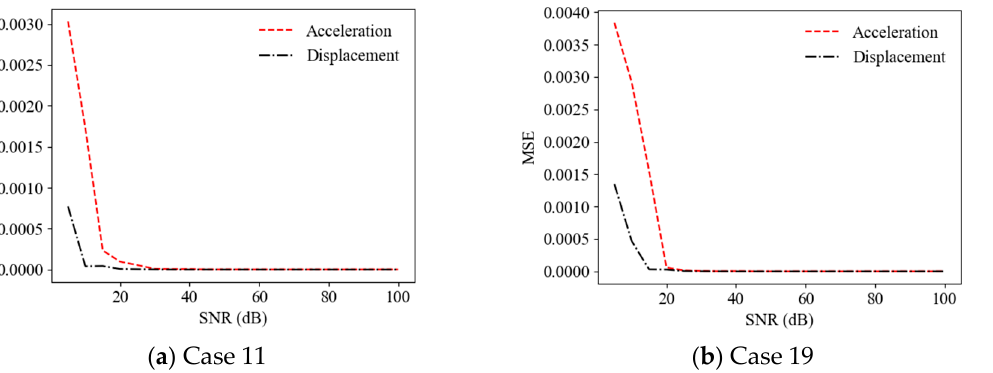
Figure 7. MSEs of prediction values versus SNRs using acceleration and displacement responses as ANN input.